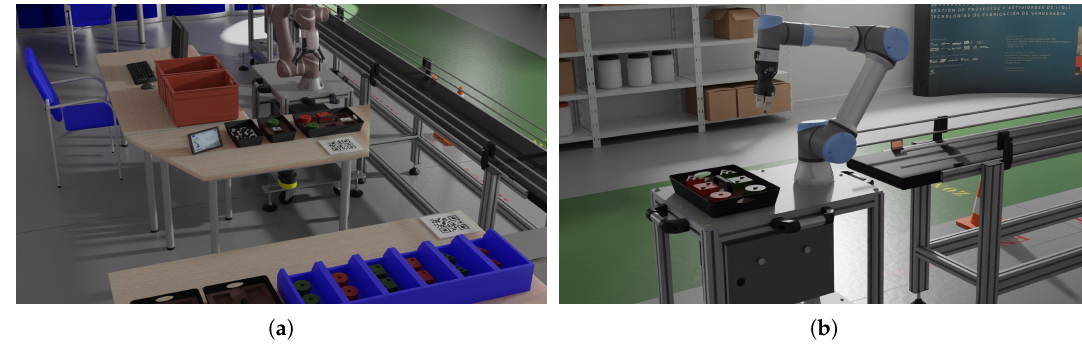
Figure 9. Virtual cell: ( a ) containers with the parts and assembly robot, and ( b ) delivery